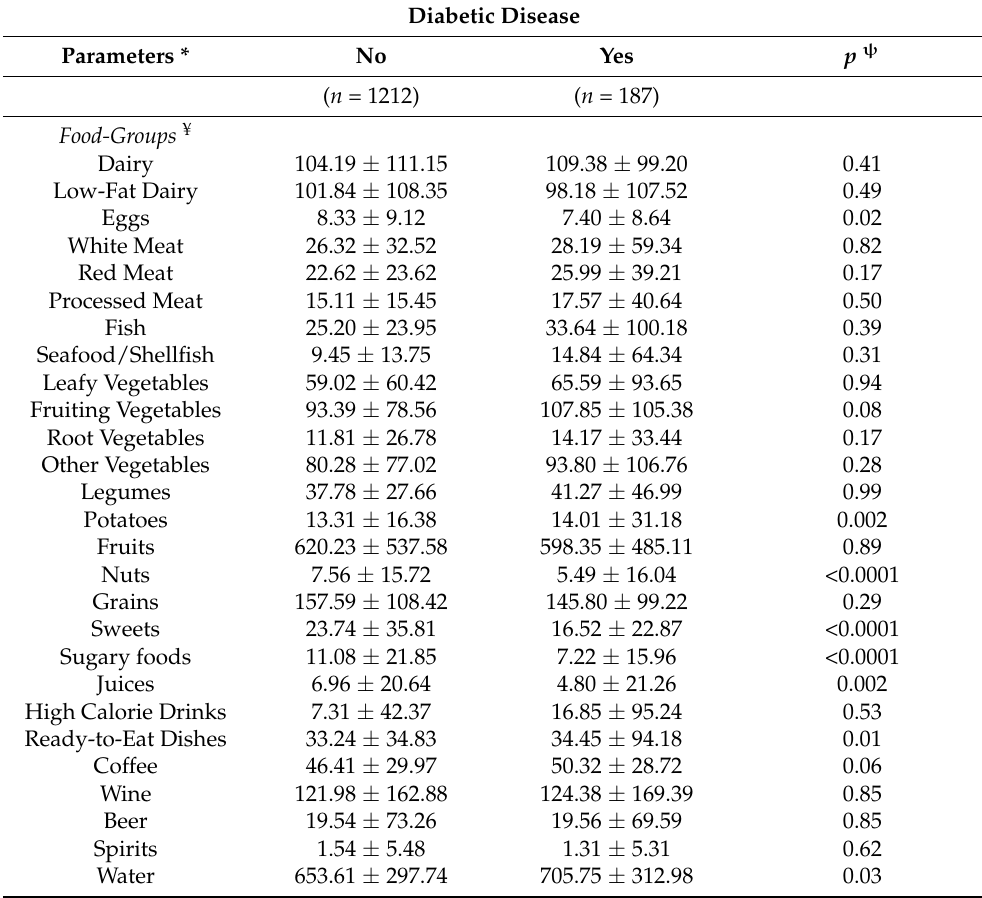
Table 2. Food groups average consumption in patients with and without diabetic disease (Yes/No). The Salus in Apulia Study ( n =